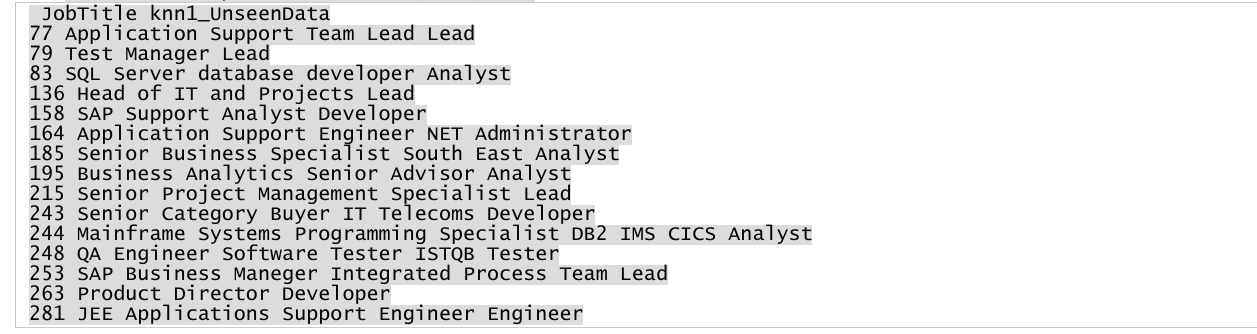
Figure 11. Comparison of job titles and predictions (unseen data).